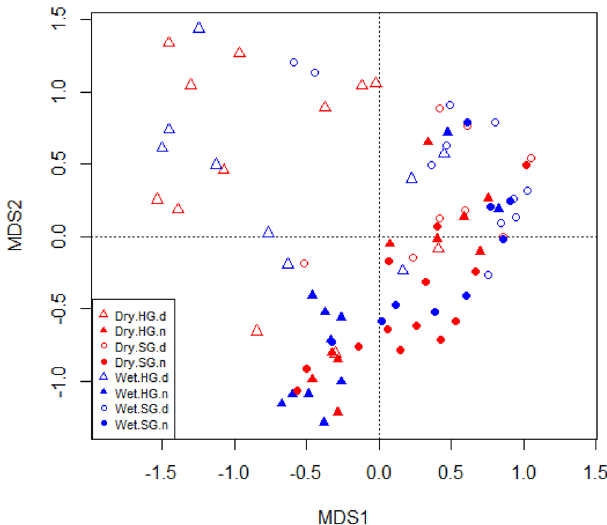
Figure 5. The MDS plot ordinates sites on the season (Dry and Wet), habitat (HG and SG) and diel ( d day and n night) activities of dung beetles. It suggests that the sites, regardless of season and habitat, are relatively closer on nocturnal community of dung beetles than on diurnal community of dung